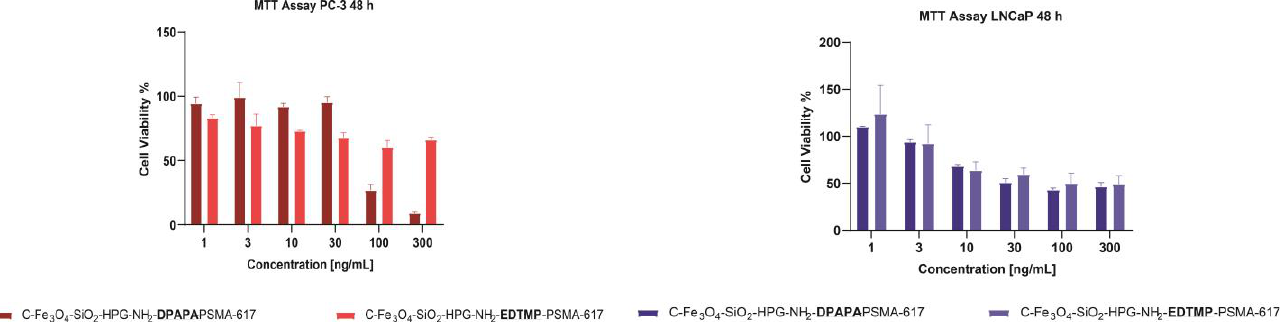
Figure 6. Cell viability of PC-3 and LNCaP cells treated with nanoconjugates after 48 h of incubation.